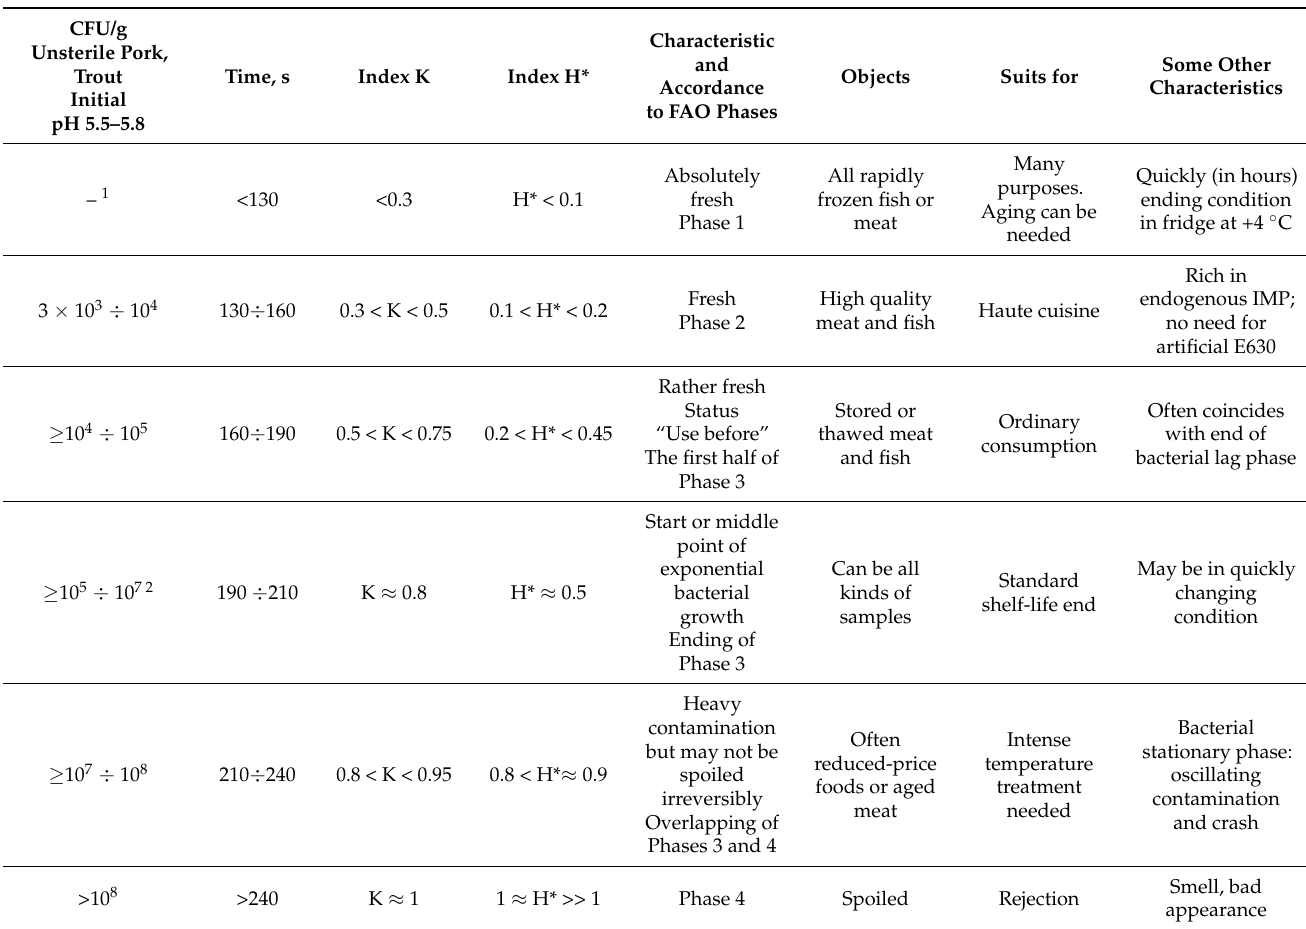
Table 3. Correlation between the consumer properties of meat and fish, Time and H* indices, and bacterial contamination